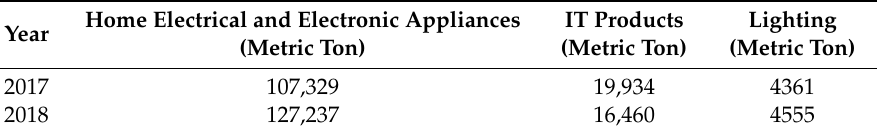
Table 5. Statistics on the amounts of recycled WEEE in